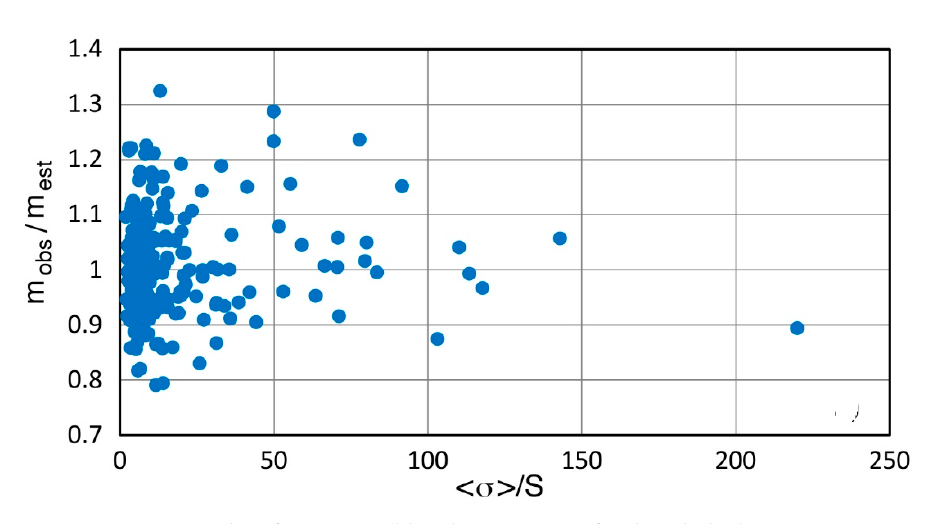
Figure 2. Plots of m obs (red + symbol) and m est (blue dot) vs. < σ >/S for the whole datasets.